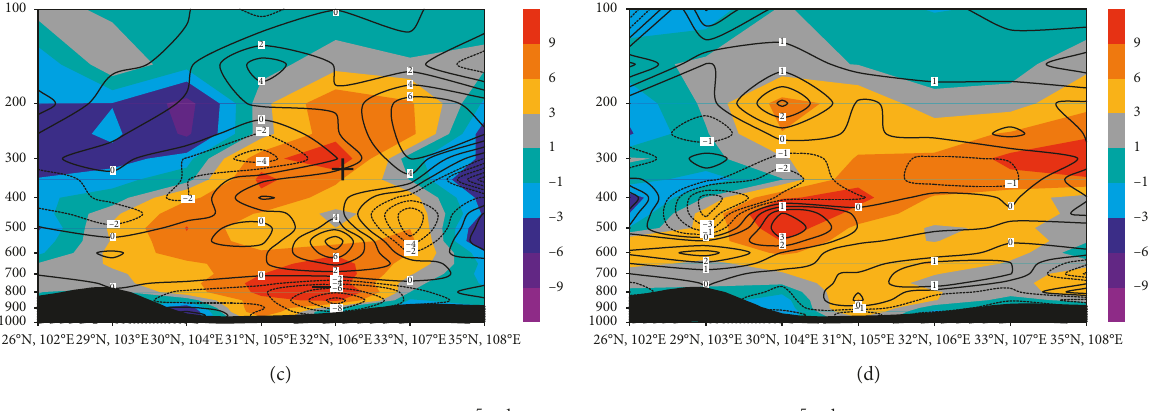
Figure 8: As in Figure 7 but for the vorticity (shaded, 10